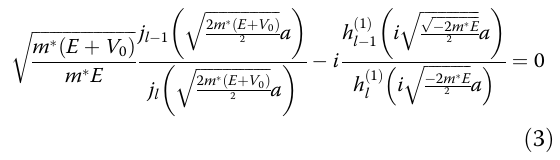
ffiffiffiffiffiffiffiffiffiffiffiffiffiffiffiffiffiffiffiffiffiffiffiffiffi p (cid:3) 2 m (cid:4) E 2